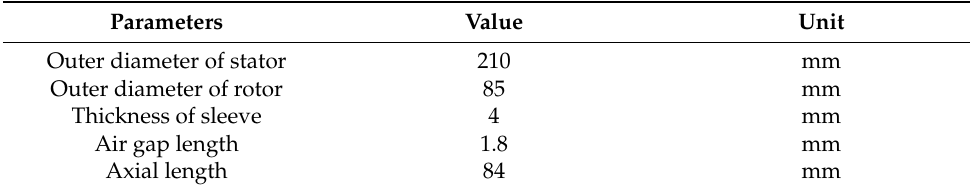
Table 6. Final design specification.